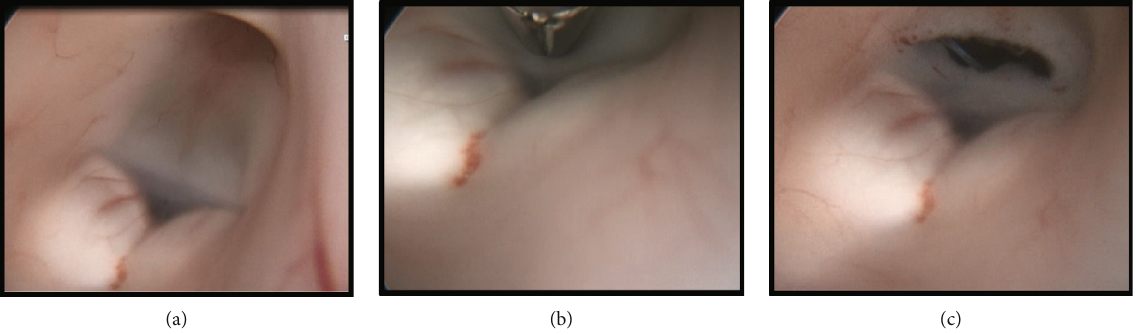
Figure 3: The image shows the endoscopic third ventriculostomy (EVT)